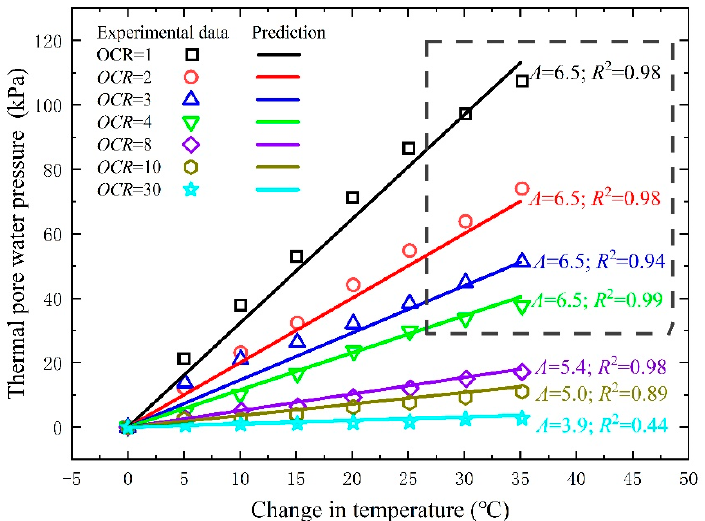
Figure 1. Comparison of predicted thermal pore water pressure against the results of Wang et al. (2017).